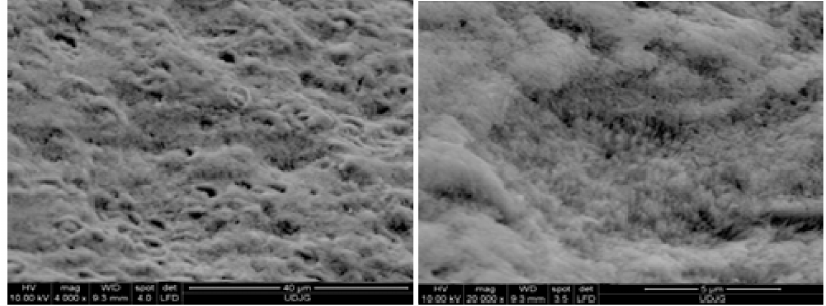
Figure 1. SEM top view images of acid-etched enamel reference sample